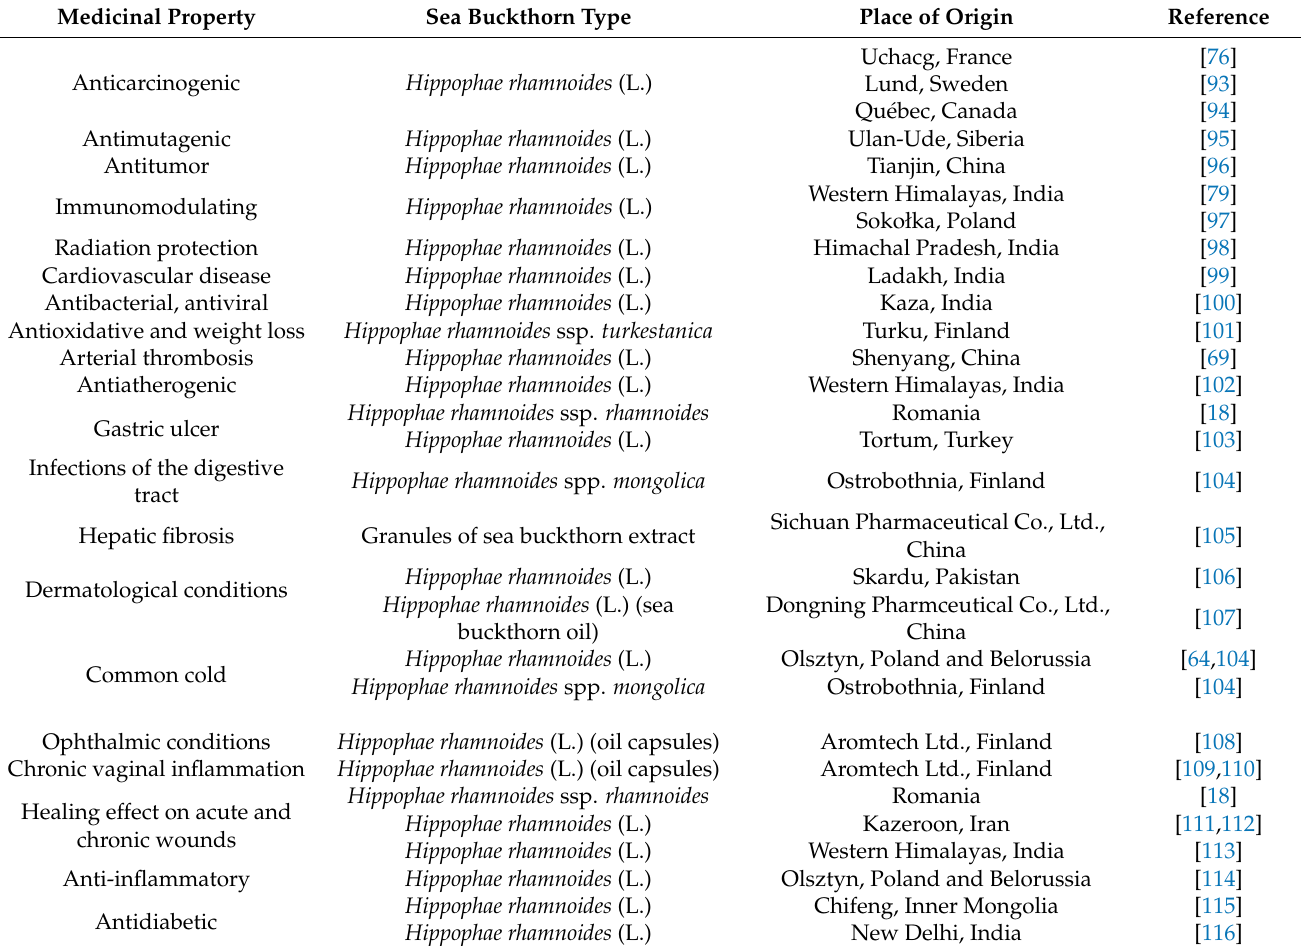
Table 6. Medicinal properties of sea buckthorn ( Hippophaë rhamnoides